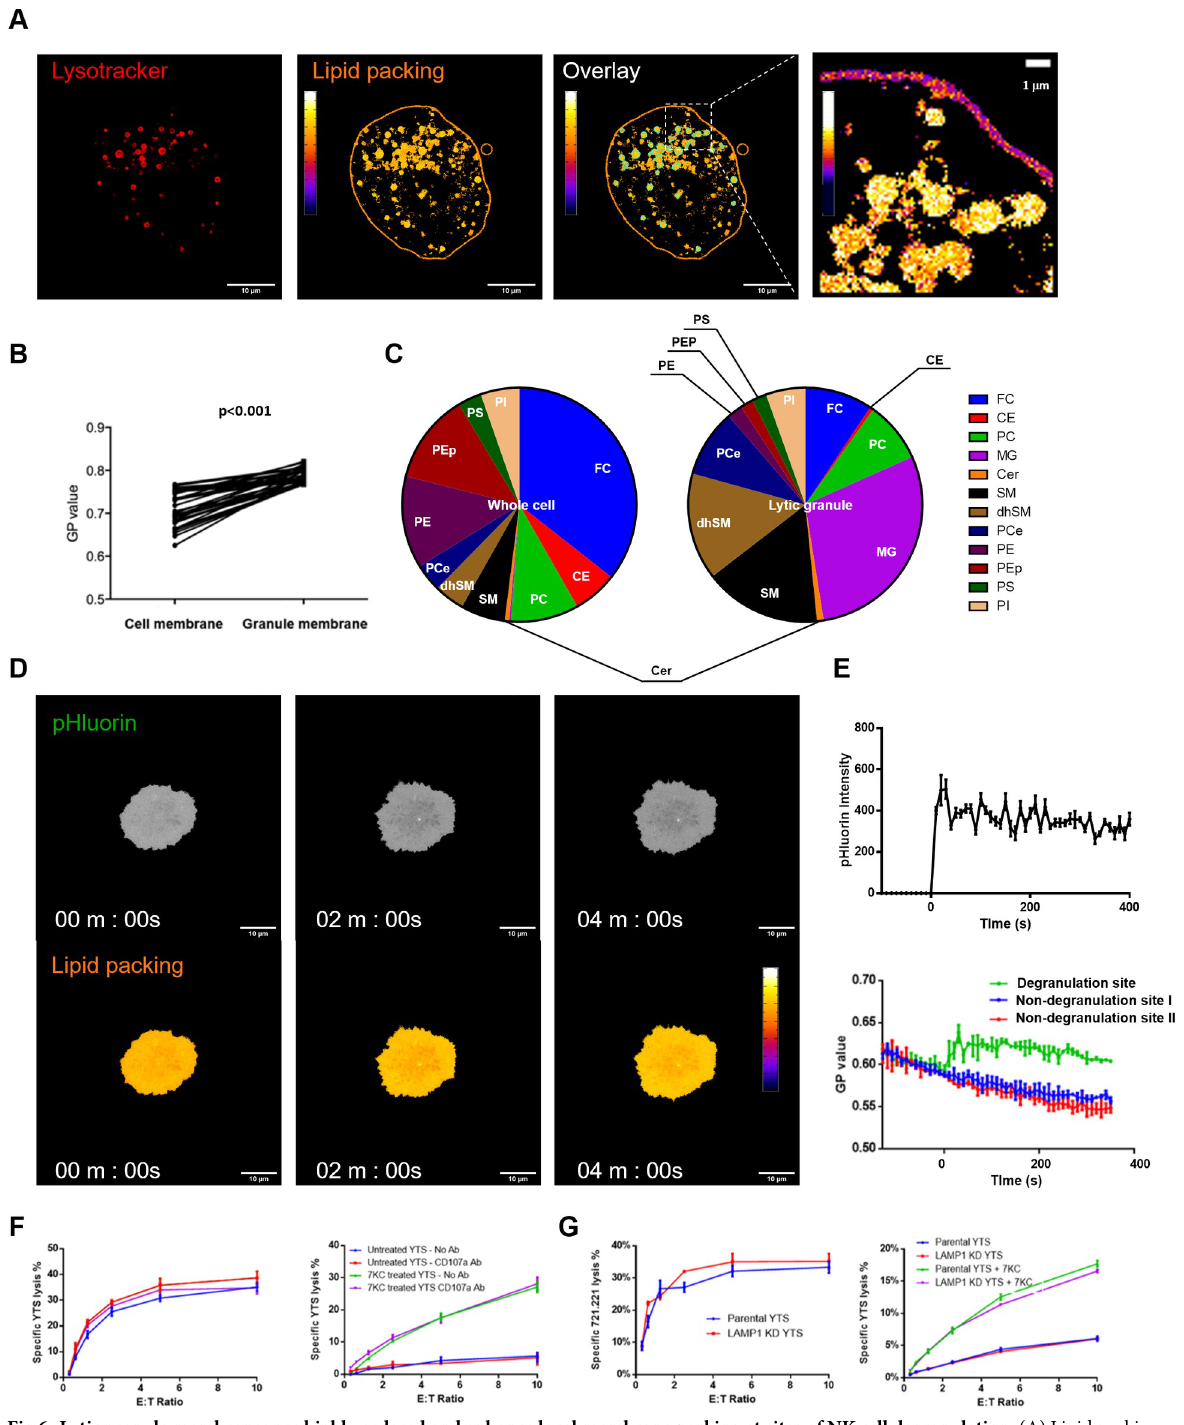
Fig 6. Lytic granule membranes are highly ordered and enhance local membrane packing at sites of NK cell degranulation. (A) Lipid packing densities of the cell membranes of nonstimulated YTS cell were measured with the fluorescent packing sensor Laurdan (pseudocolor scale, middle), and lytic granules were identified using lysotracker dye (red, left). The overlay of the 2 fluorescent channels was used to identify lytic granules (using an object identifier in ImageJ software–outlined in teal), which allowed for the measurement of lipid packing density at the location of the lytic granules (pseudocolor scale). An enlargement (right) shows the lipid packing of lytic granule membranes and cell membrane with an expanded pseudocolor scale using a more refined range to amplify lipid packing differences. (B) Lipid packing density was quantified in the region of the lytic granules as determined by lysotracker colocalization as the GP value of this colocalized region and was compared to the GP value of the entire cell